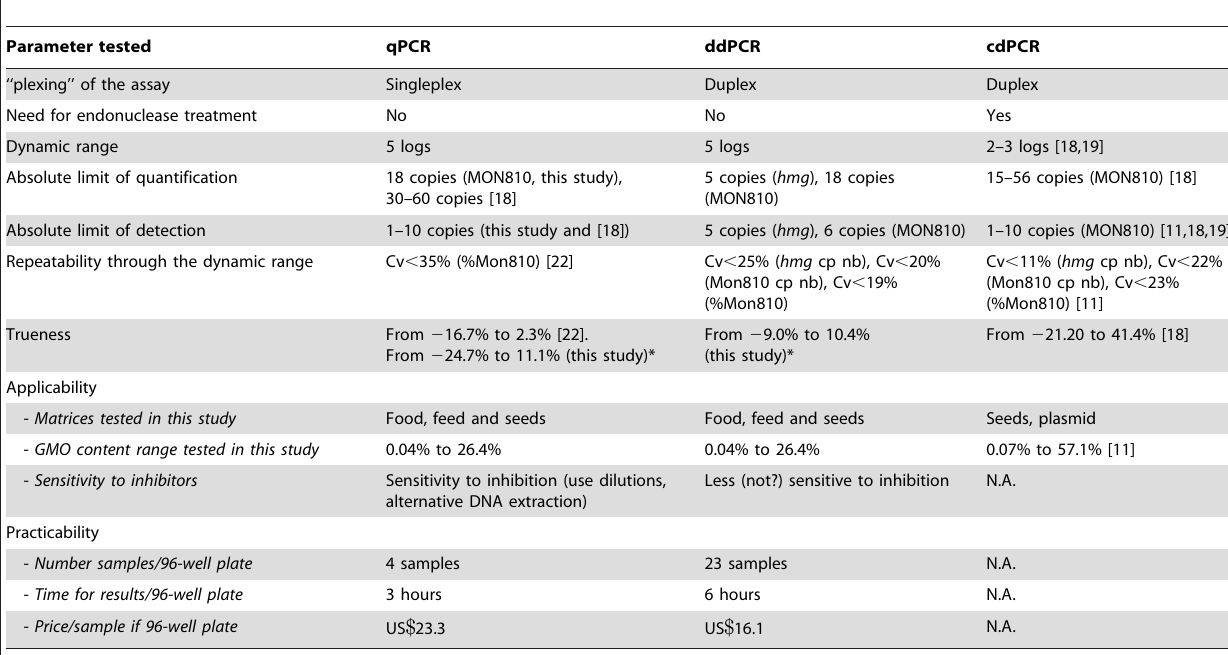
Table 2. Summary table of qPCR, ddPCR and cdPCR performance for MON810 detection and quantification.